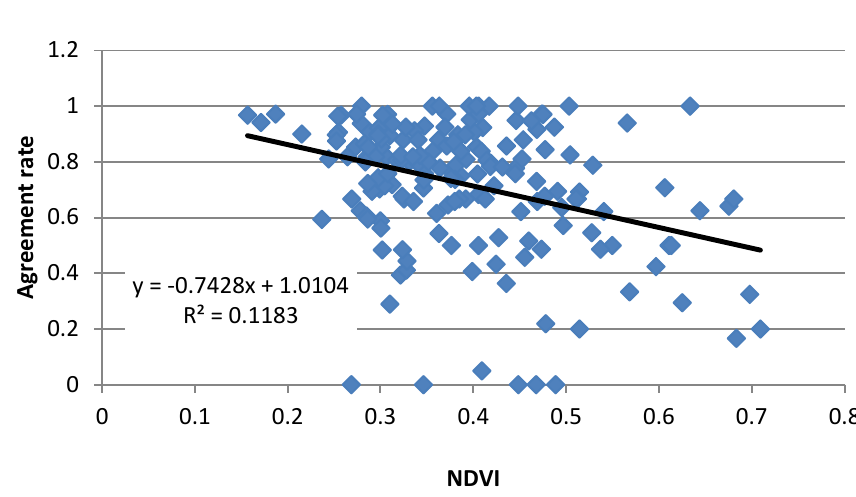
Figure 10. Agreement rate for each sample point as a function of its average NDVI value across all study image dates. While scene-level agreement decreases with increasing vegetation cover, NDVI discerned from the satellite data themselves fails to explain model performance at this scale.